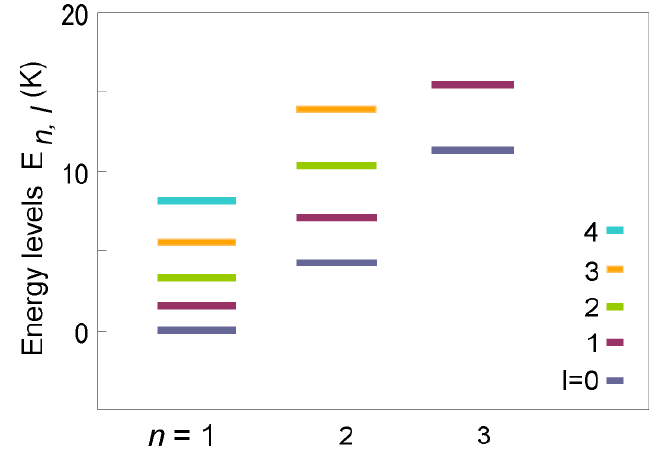
Figure 8. (Color on line) Schematic representation of the translational energy levels for hydrogen deuteride molecules constrained to a cage 15 Å in